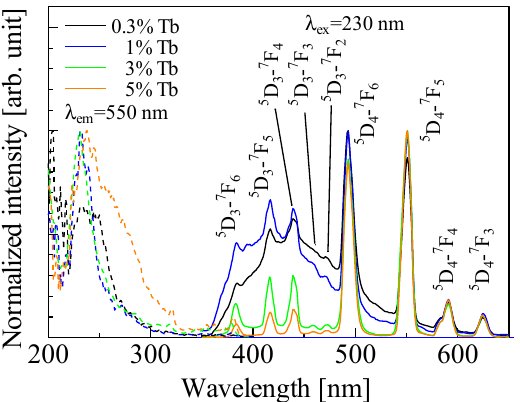
Figure 4. PL excitation (dashed line) and emission (solid line) spectra of Tb-doped MgGa 2 O 4 . Table 1. PL QY and decay time constants of the